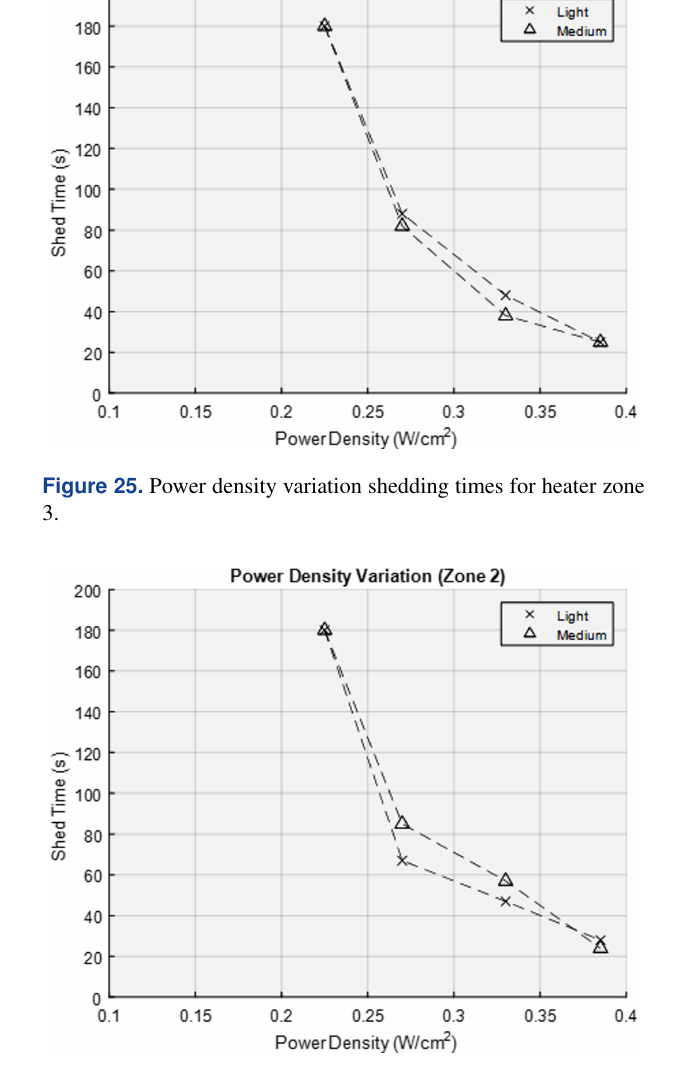
Figure 26. Power density variation shedding times for heater zone 2.